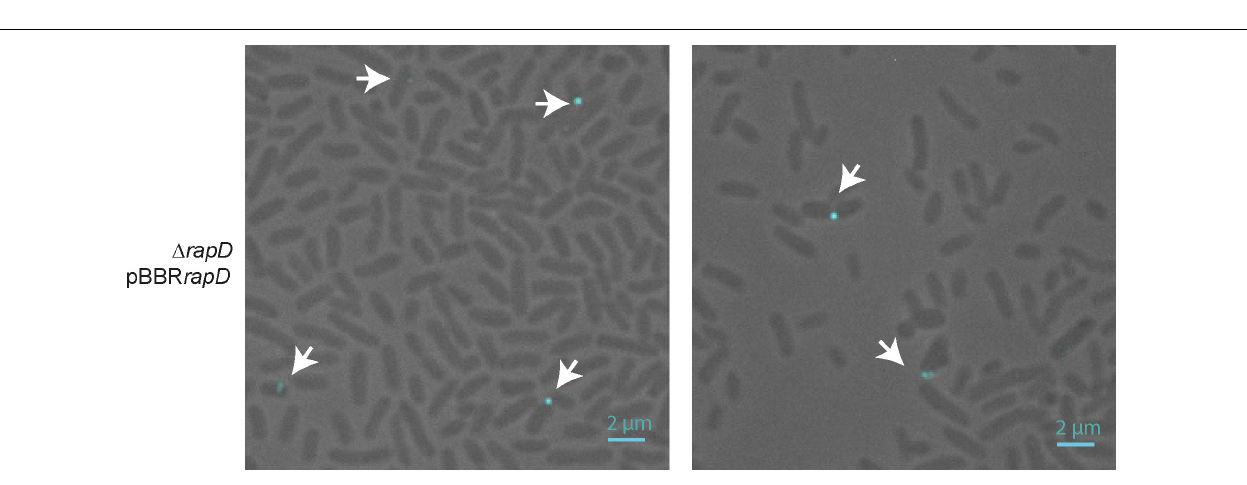
FIGURE 4 | Immunofluorescence of RapD. Representative fields for the RapD overexpressing strain grown for 20 h in TY medium detected with anti-RapD antisera and anti-mouse Cy3–conjugated secondary antibodies are shown. Cells were observed at 1000X. The size bar represents 2 µ m and white arrows indicate polar signals of